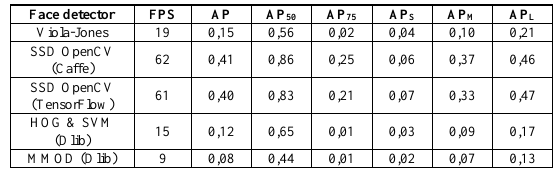
Table 1. Comparative analysis of face